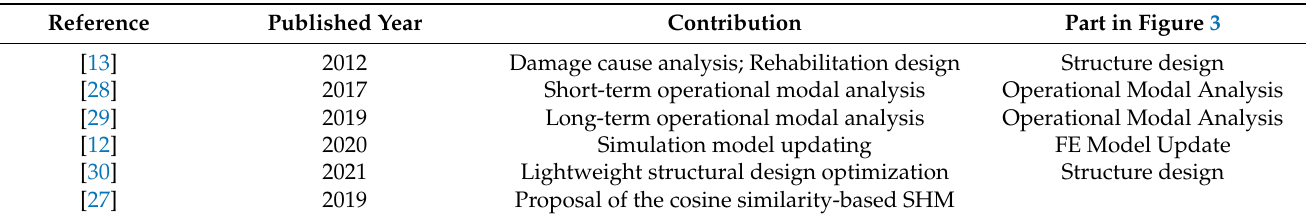
Table 1. Summary of recent research studies relevant with this topic.